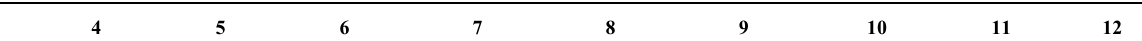
Table 3. Pair-wise correlation matrix of all